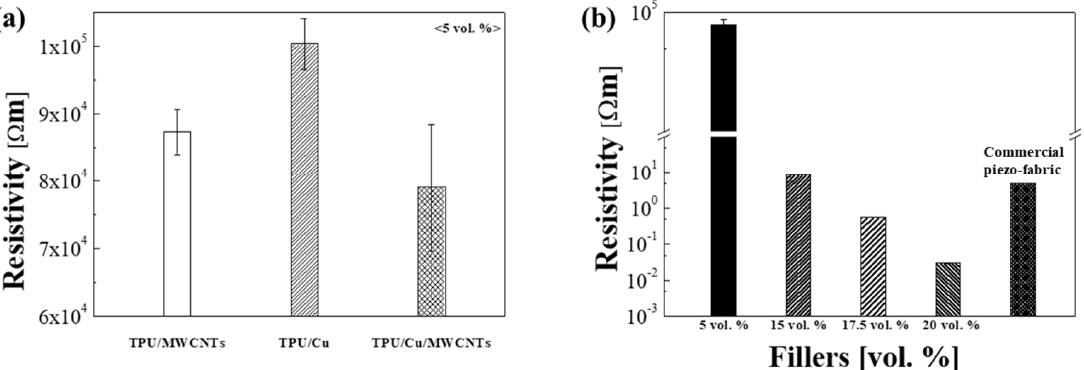
Figure 5. ( a ) Resistivity of the different fillers containing TPU at the same volume fraction; ( b ) resistivity of the 3D-printed TPU/Cu/MWCNTs compared with commercial piezoresistive fabric at different volume fractions.